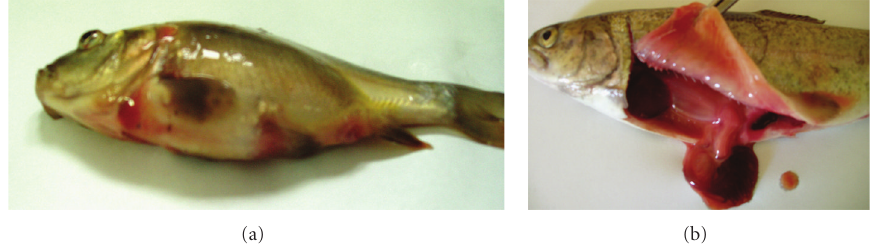
Figure 4: Septicaemia in fish Ip challenged with A. veronii bt. sobria strain K151 (a) and A. hydrophila strain Pt104 (b): exophthalmia, swelling of abdomen, and intensive congestions on the body surface in carp (a); enlarged spleen, intensive congestions, and liquefaction of internal organs in trout (b).